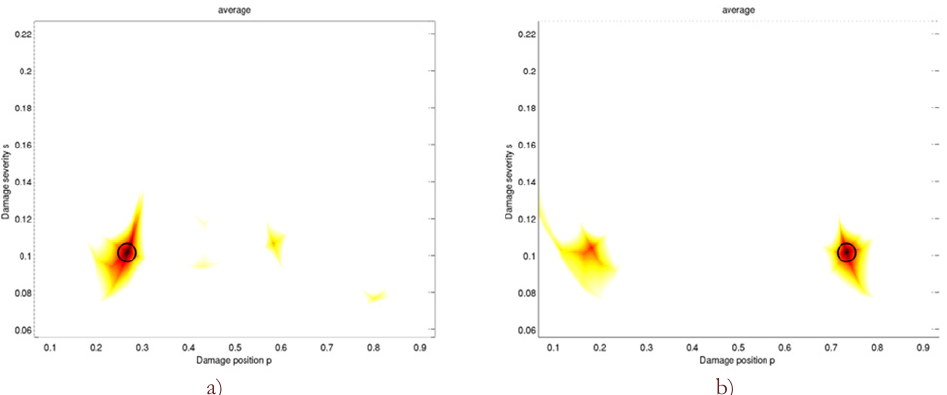
Figure 5: Nonlinear harmonic identification on the simply supported beam. The system is excited at l F / l =0.45 ; a) p = 0.27, s = 0.1; b) p =0.73 s = 0.1.